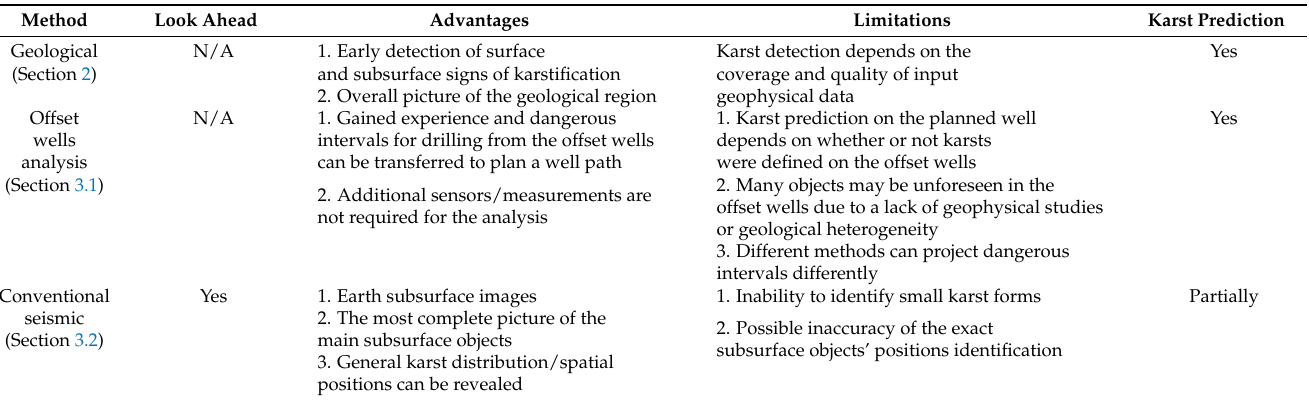
Table 2. Pre-drill karst detection